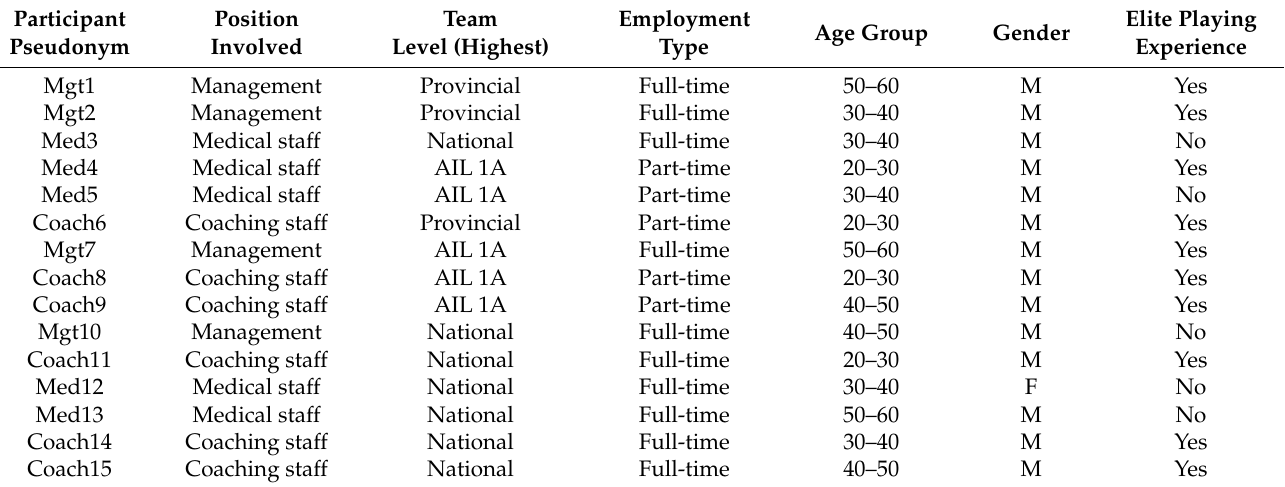
Table 1. Participants’ Background